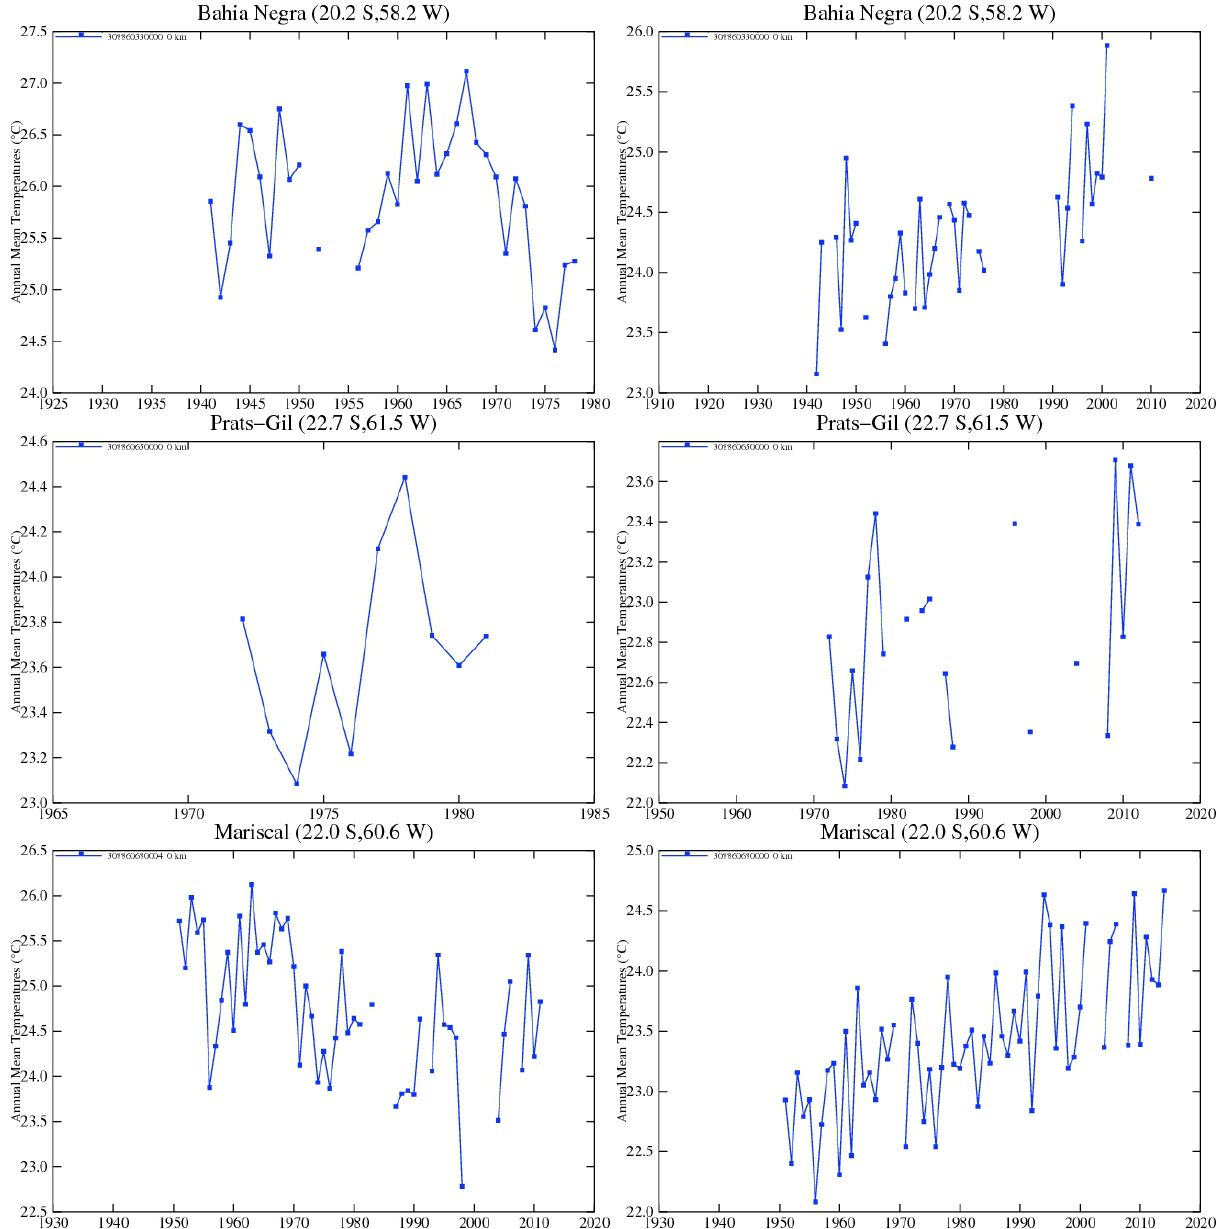
Fig. A.1: GISS v2 vs. v3 temperature records for all the stations of Paraguay. In all cases coolings or no warmings have been transformed in significant warmings claiming impossible homogenization with previously massaged data. GISS v2 data on the left, GISS v3 data on the